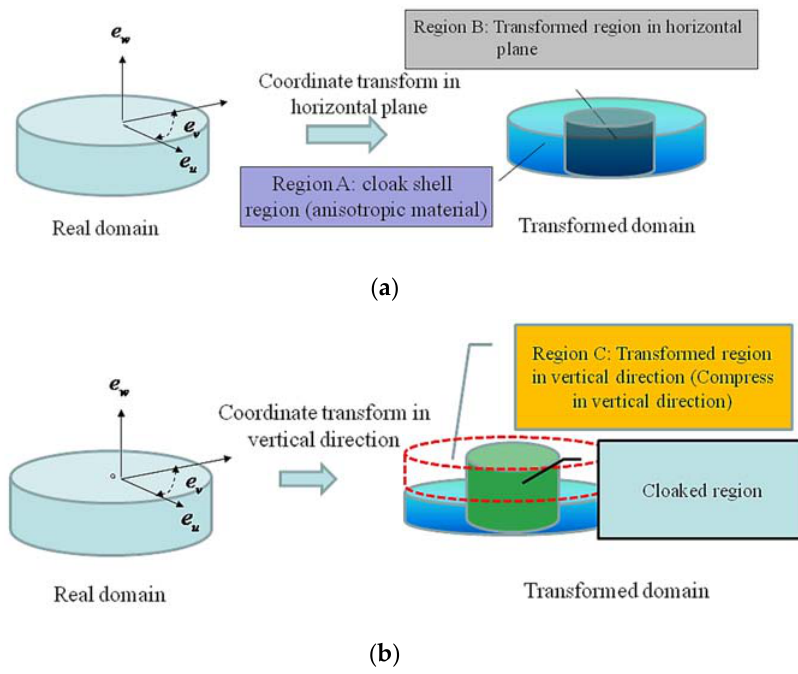
Figure 1. Design of circle cloak using transformation acoustics: ( a ) after coordinate transformation, Region B no longer exists in the transformed domain, thereby making the object within inaccessible to incident waves. This makes the material properties of the cloak shell (Region A) anisotropic and inhomogeneous. ( b ) Geometric transformation in the vertical direction, w e , wherein the space in Region C no longer exists in the transformed domain. This operation essentially converts the space within the transformed domain into the equivalent of a thin plate in order to achieve acoustic invisibility for the three-dimensional object.